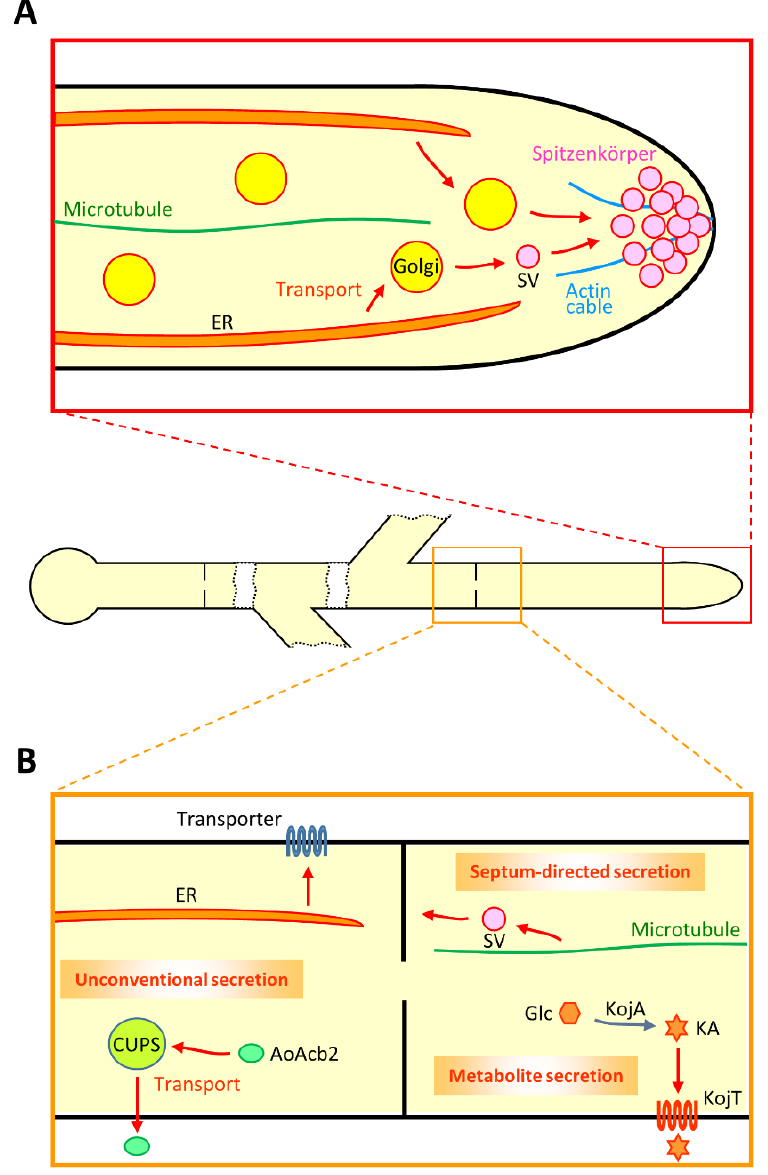
Figure 1. Secretory pathway in A. oryzae . ( A ) Secretion mechanisms at the hyphal tip region are depicted. Secretory proteins are transported via vesicles from ER through Golgi to the apical vesicle cluster Spitzenkörper. Apical secretion is thought to be dependent mainly on actin cable and sup- portively on the microtubule. SV, secretory vesicle. ( B ) Secretion mechanisms to the septum and plasma membrane around the hyphal middle region are shown. Septum-directed secretion is dependent on the microtubule but independent of the actin cytoskeleton, but further detailed molecular mecha- nisms are unknown. The cytoplasmic acyl-CoA binding protein AoAcb2 is unconventionally secreted under carbon starvation conditions, in which a compartment for unconventional protein secretion (CUPS) might be involved. Plasma membrane transporters are potentially transported directly from ER, not via Golgi. As an example of secondary metabolite secretion, kojic acid (KA) is synthesized from glucose (Glc) by the biosynthetic enzyme KojA and secreted by the putative plasma membrane transporter KojT. Note that the localization and transport of plasma membrane transporters do not appear to be restricted around the hyphal middle